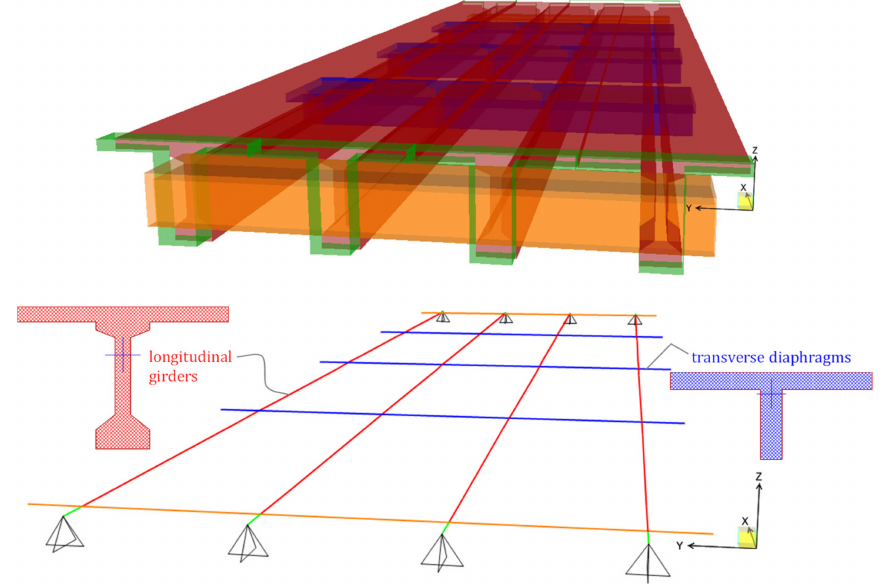
Figure 11. FE model of the bridge deck with 1D beam elements: extruded and standard view.